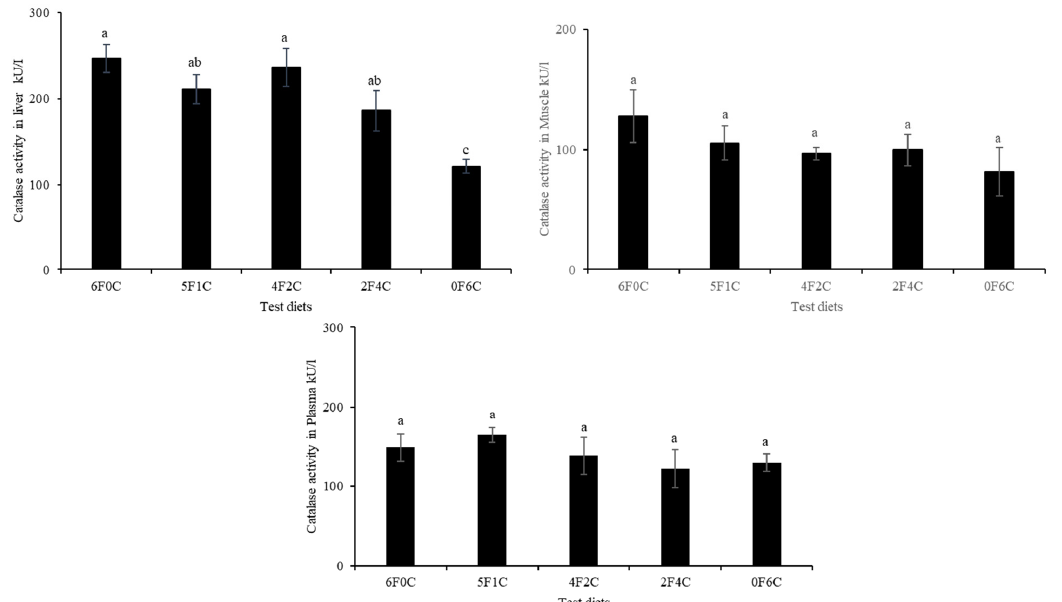
Figure 1. Catalase activities in liver, muscle, and plasma of red seabream after 56 days of the experimental period. Absence of superscript letters refers to non-significant differences between treatments ( p > 0.05) and presence of different superscript letters refers to significant differences between treatments ( p < 0.05).